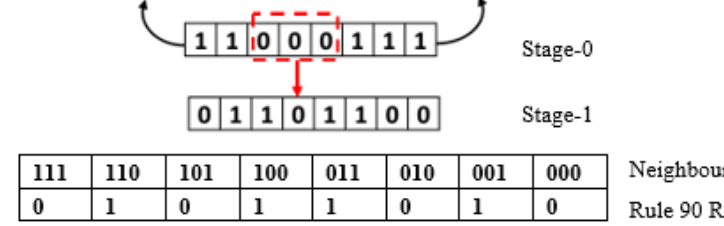
Figure 1. Cellular automation rule 90 with radius = 1.